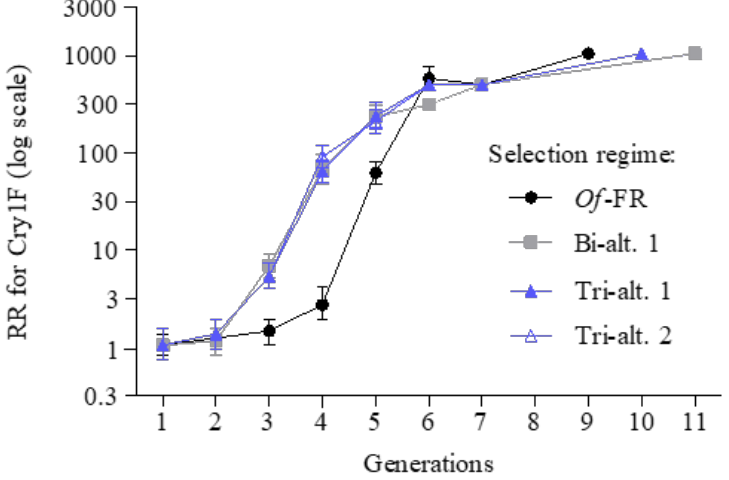
Figure 2. Evolution of resistance to Cry1F in O. furnacalis with different Bt toxin treatments. Of -FR,